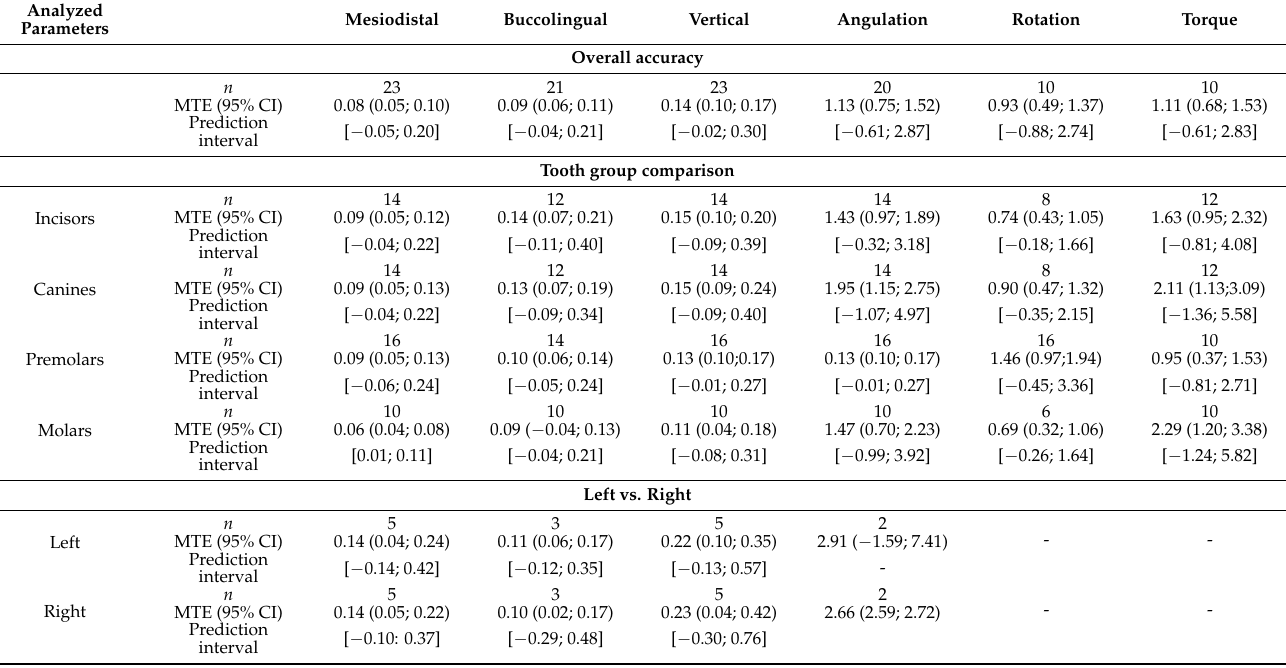
Table 4. Summary of the results of the meta-analysis. MTE, mean transfer